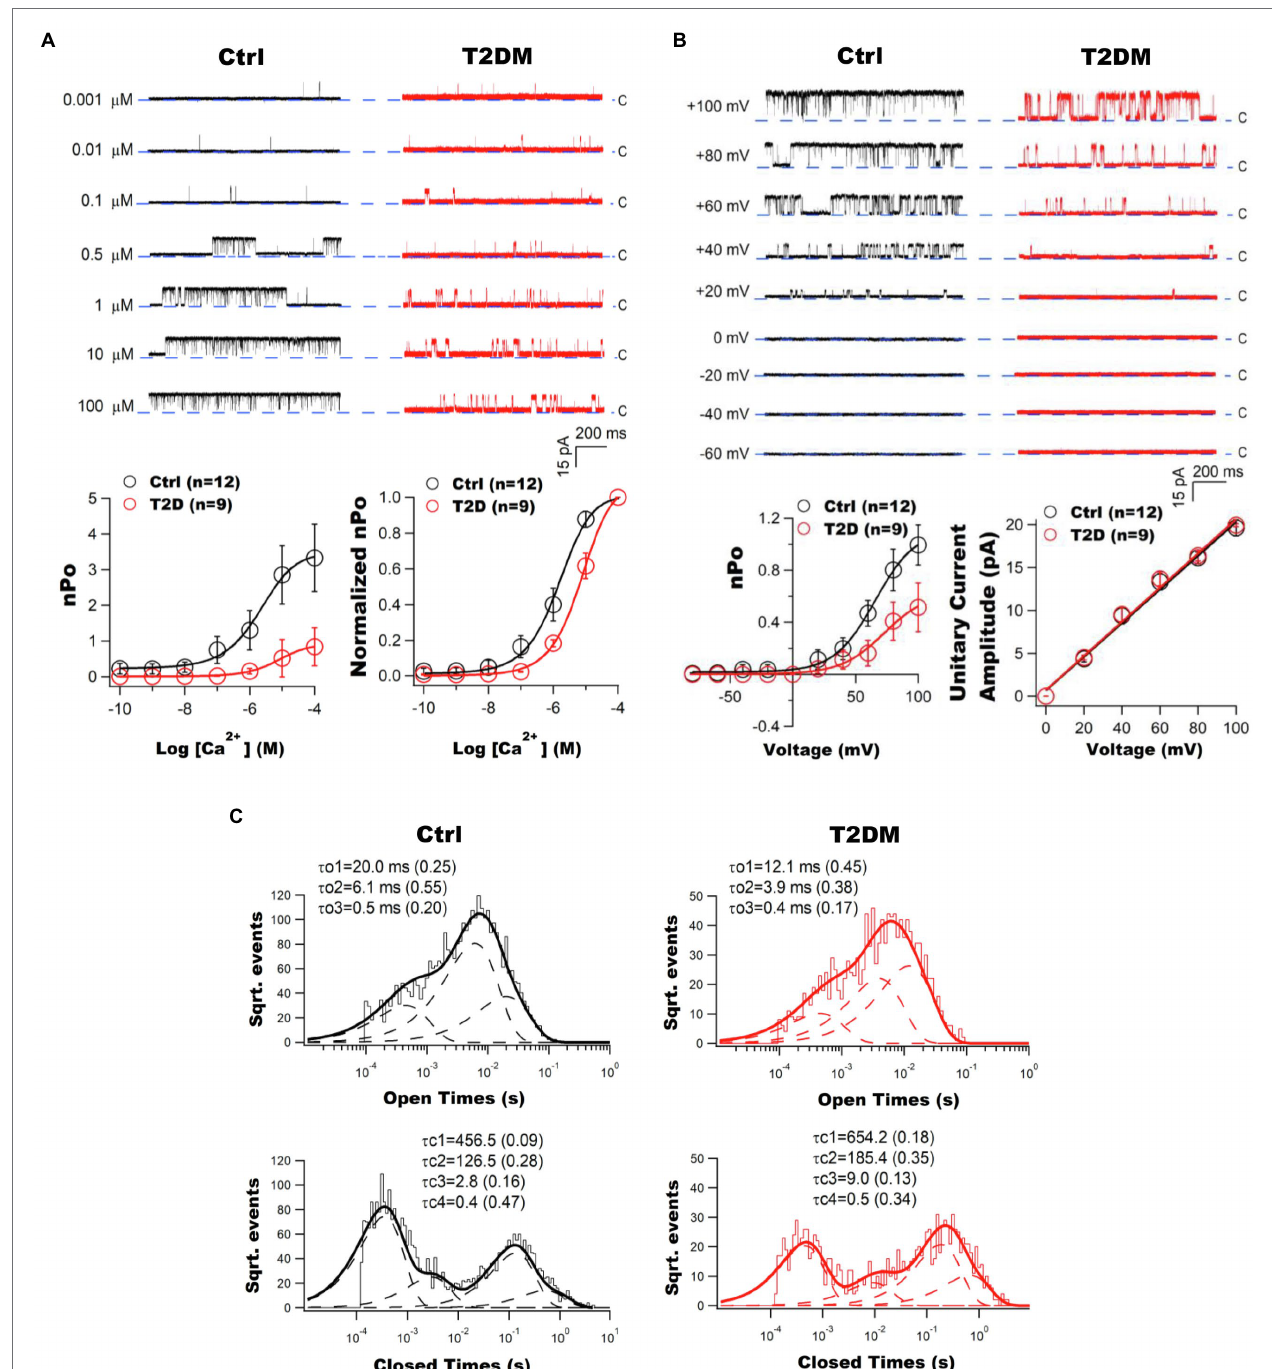
FIGURE 2 | Impaired vascular BK channel function in patients with T2DM. (A) Coronary arterioles of T2DM patients exhibit diminished BK channel Ca 2+ sensitivity. Left panel: Representative tracings of inside-out single BK channel currents recorded at +60 mV in an excised patch of freshly isolated atrial coronary arteriolar myocytes from non-diabetic (Ctrl) and T2DM patients. With an increase in free Ca 2+ concentration, BK channel open probability (nPo) was robust in controls but not in T2DM patients. Dashed lines indicate the closed state (c) of channel. Right panel: The nPo plotted against logarithm Ca 2+ concentrations (nPo-log[Ca 2+ ] curve) was fitted using the Hill equation. There were significant reductions in Ca 2+ log[EC 50 ] and BK channel maximal nPo in T2DM patients ( n = 9) compared to those in non-diabetic controls ( n = 12). A rightward shift on the normalized nPo-log[Ca 2+ ] curve of T2DM patients. Data are presented as mean ± SEM. The BK channel maximal nPo and log[EC 50 ] were significantly reduced in diabetic patients. (B) Impaired BK channel voltage sensitivity in the coronary arterioles of T2DM patients. Left panel: Representative tracings of inside-out single BK channel currents elicited at different